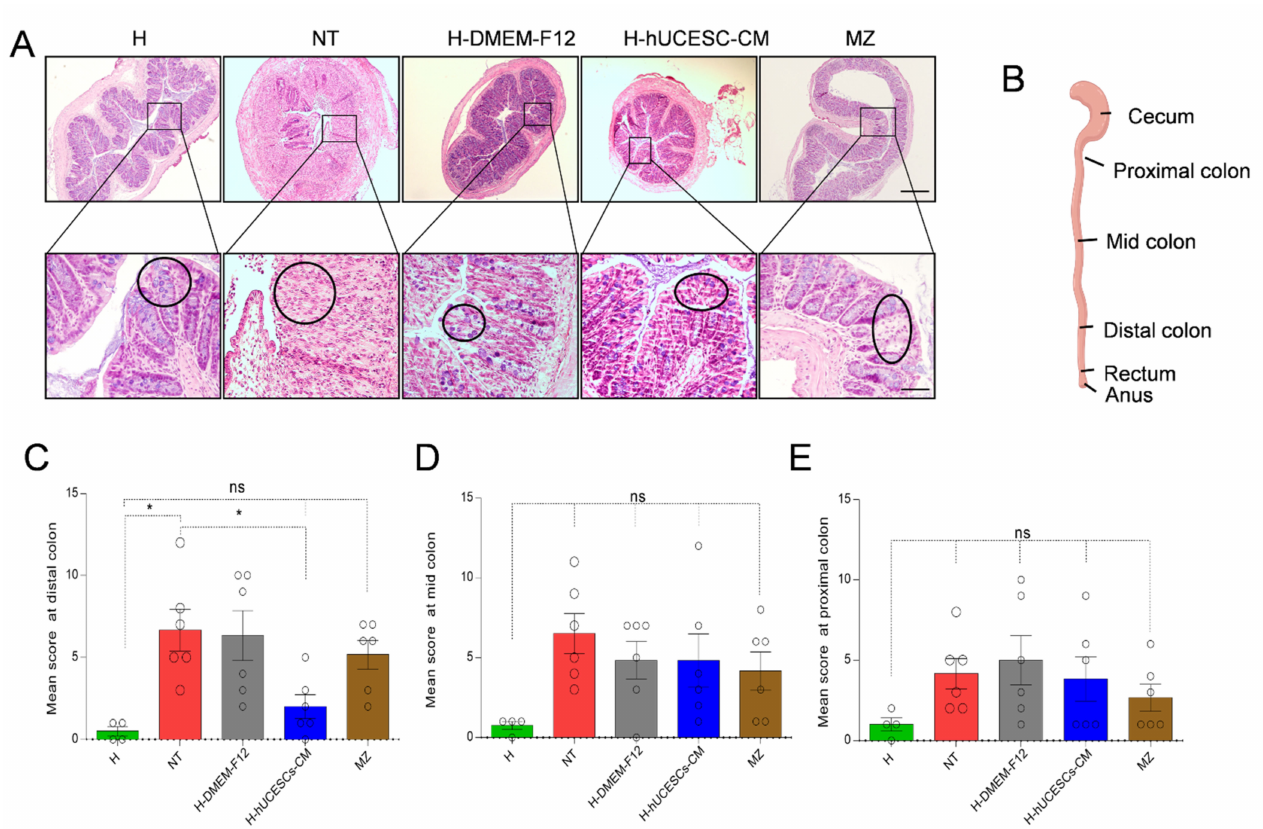
Figure 5. Histological evaluation of colon. ( A ) Representative mice colon sections stained with H&E. Microphotographs shown areas of normal epithelium (H), ulceration and severe inflammatory reaction (NT), glandular distortion (H-DMEM- F12), mild inflammation (H-hUCESC-CM), and atrophy (MZ). ( B ) Representative picture of histological analysis. Analyses were done in three colonic fragments: distal, mid, and proximal (with respect to cecum). ( C ) Colon epithelial score in the distal fragment (based on inflammation and cell infiltration, microscopic ulcerations, crypt architecture, epithelial atrophy, and epithelial dysplasia, see Methods). ( D ) Colon epithelial score in the middle fragment. ( E ) Colon epithelial score in the proximal fragment. Data are expressed as mean ± SEM. H: healthy mice, NT: non treated mice, H-DMEM-F-12: DMEM- F12-loaded hydrogel treated mice; H-hUCESC-CM: H-hUCESC-CM-loaded hydrogel treated mice; MZ: mesalazine-treated mice. * = p < 0.05; ns = not significant. Scale bar: 500 µ m for low (upper) and 100 µ m for high (below)